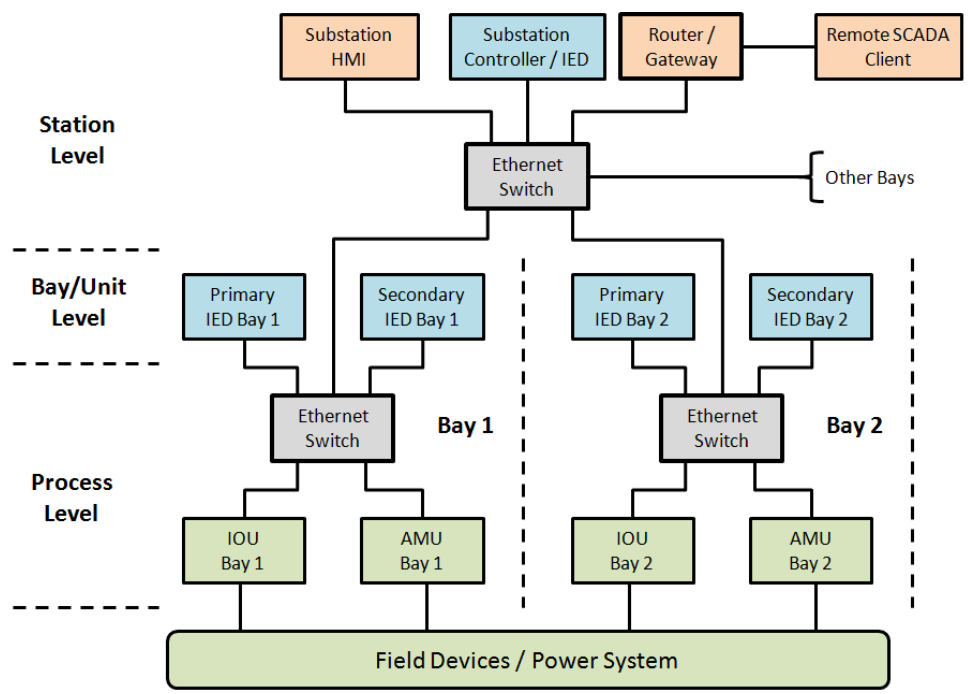
Figure 2. Layout of bridged local area networks (LANs) in a substation, showing the station LAN and multiple process LANs.